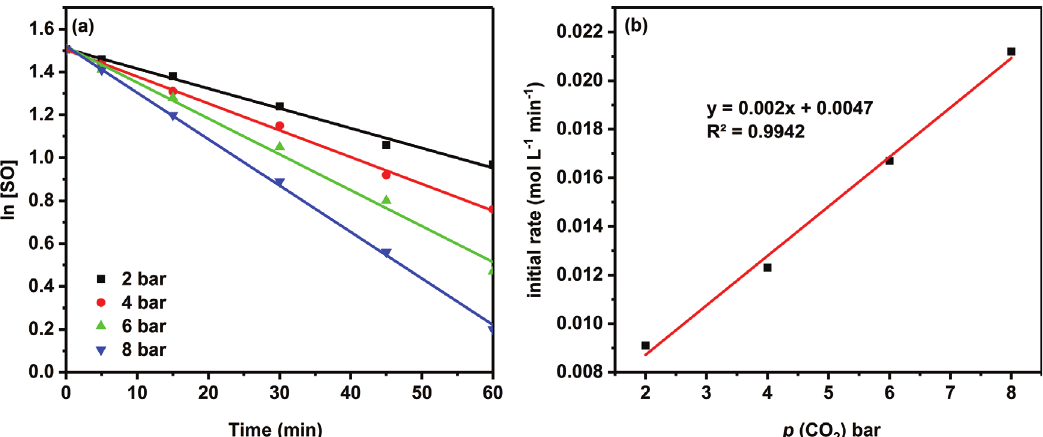
); (b) Plot showing a linear dependence of 2